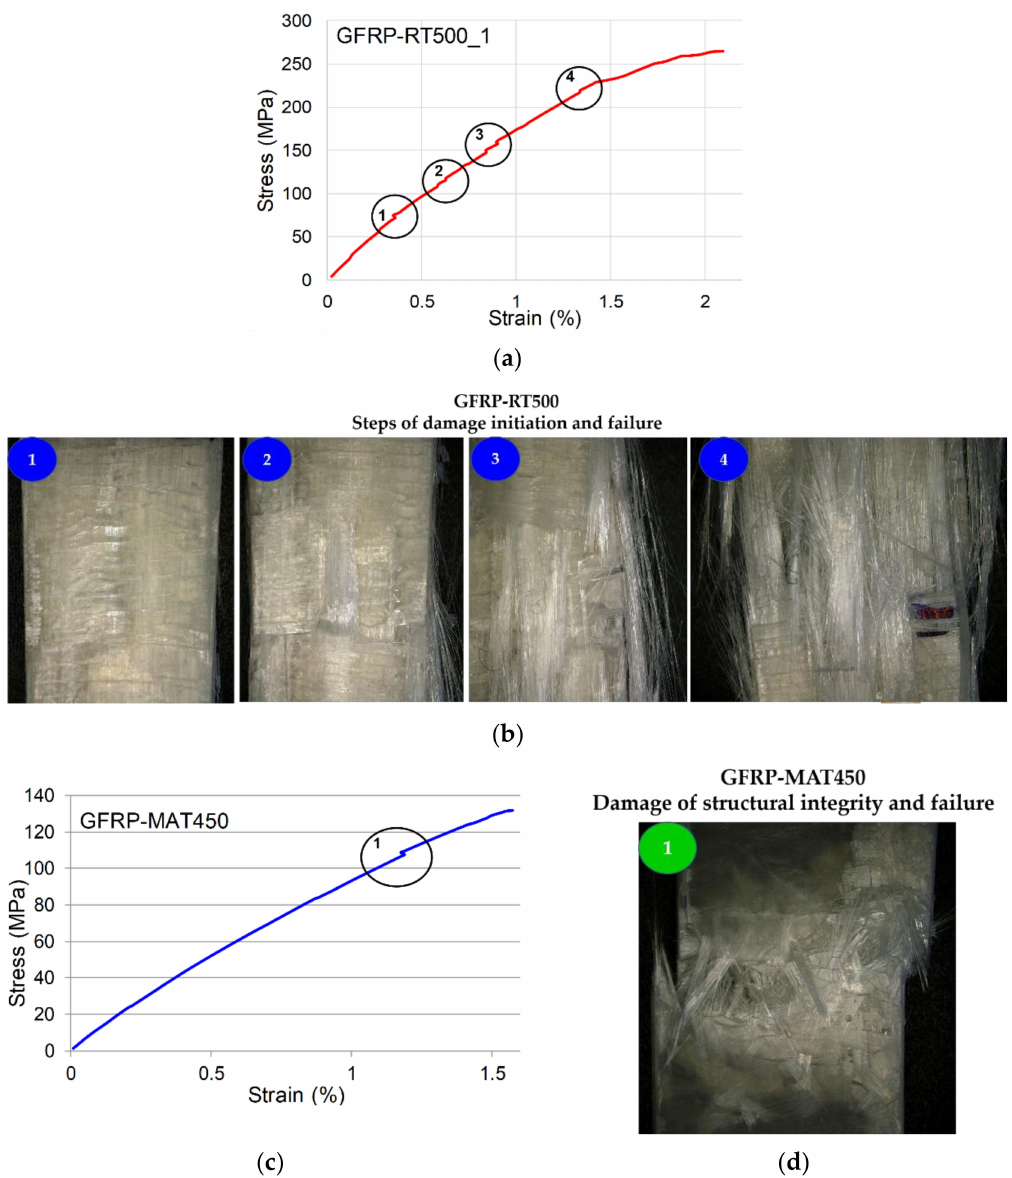
Figure 3. Correlation between stress–strain curves and damage of structural integrity of the two types of GFRP samples: ( a ) GFRP-RT500; ( b ) the microscopic images of damage initiation and failure of GFRP-RT500; ( c ) GFRP-MAT450; ( d ) failure mode of